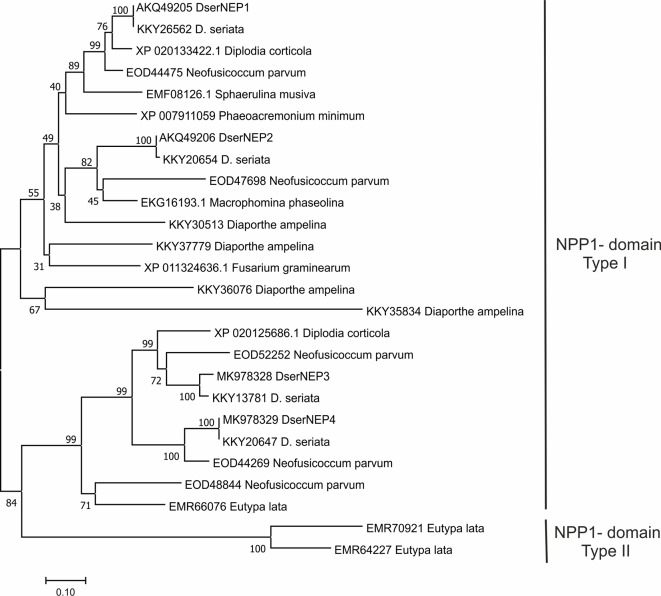
Phylogenetic tree of D. seriata NEP proteins with necrosis and ethylene inducing peptide 1-like proteins from GTD-related fungi. The figure shows the result of a Neighbor analysis performed using the MEGA 5.0 package (Tamura et al., 2011). Percent bootstrap values (1,000 replicates) are shown above the forks. The scale bar represents 10% weighted sequence divergence.